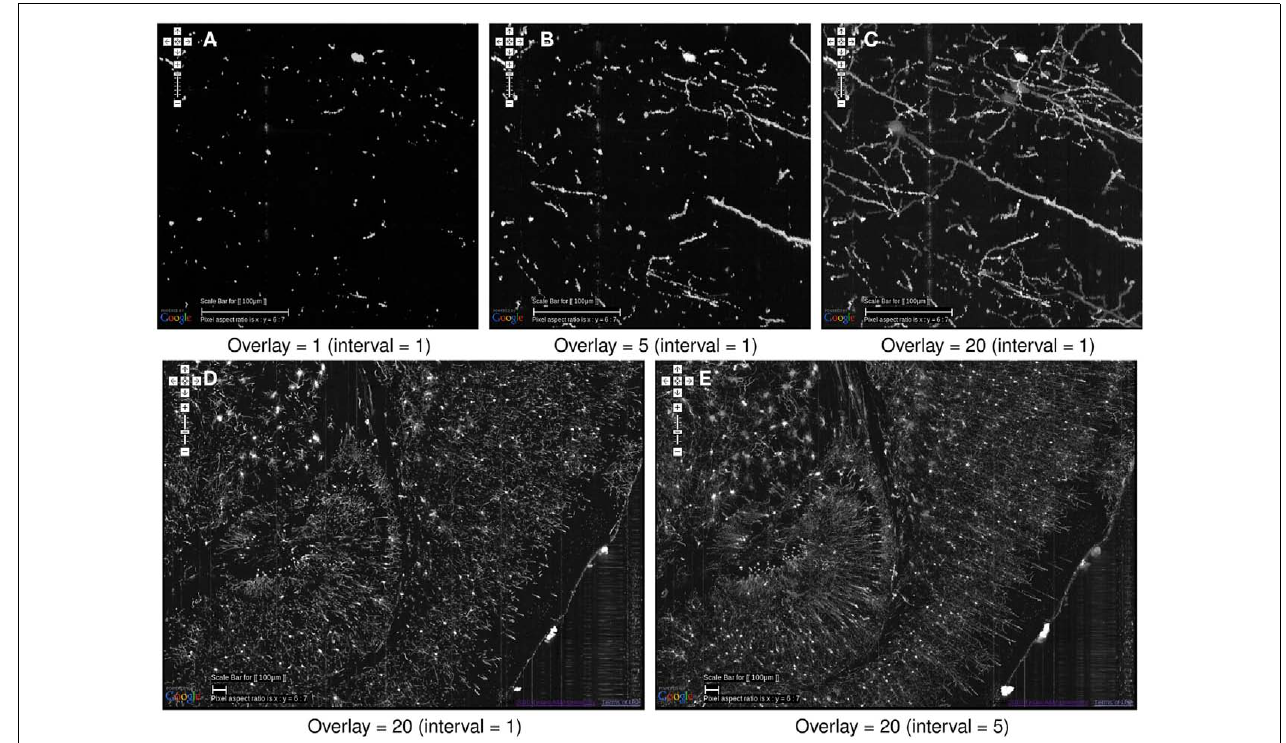
zoomed-out scale, skipping over images can be an effective strategy to view the circuits more clearly. In (D) , 20 overlays at an interval of 1, representing a 20- μ m-thick volume is shown. In (E) , 20 overlays at an interval of 5 is shown, representing 100 μ m.The dense dendritic arbor in the hippocampus (left), fiber tract projecting toward the hippocampal commissure (middle, top), and the massive number of pyramidal cells and their apical dendrites (right) are clearly visible only in (E)